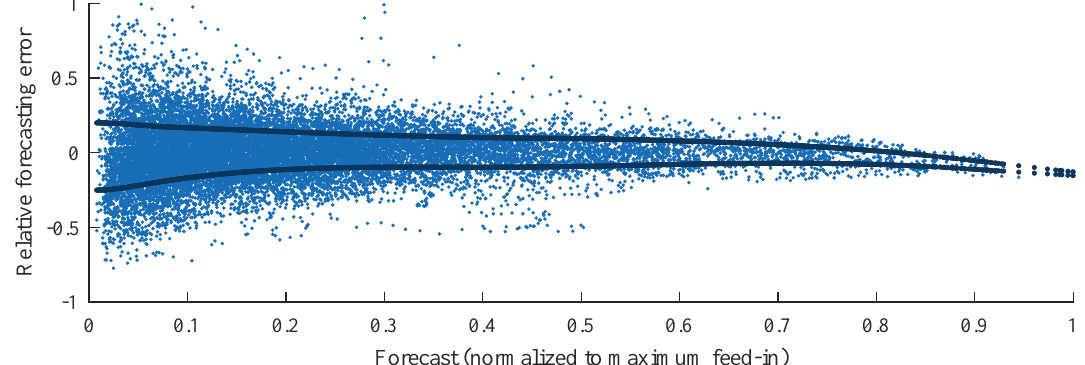
Figure 2. Dependence of the standard deviation of the wind forecasting error (dark blue) on the forecast level (based on data from